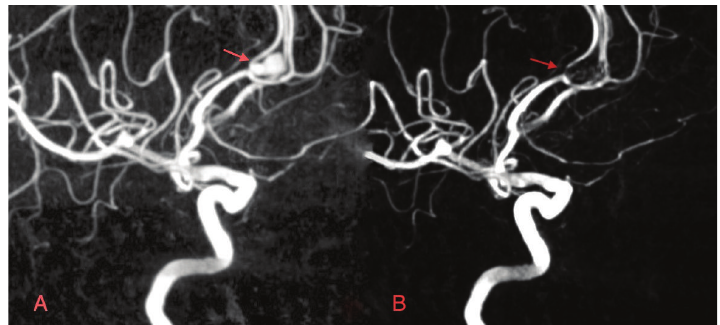
Figure 1: (a) Preoperative 3D digital subtraction angiogram (DSA) of a left 6.6 mm pericallosal UIA. 54-year-old female patient had prior history of SAH and harbored multiple smaller aneurysms on the right. Endovascular coiling was chosen. (b) Postoperative 3D DSA. Treatment achieved 99%